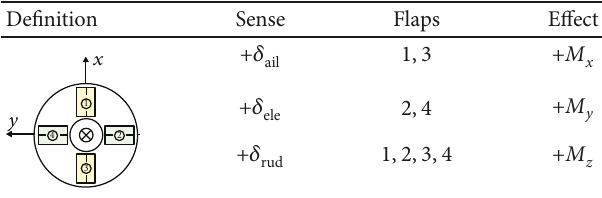
Table 1: Control surface sign conventions.